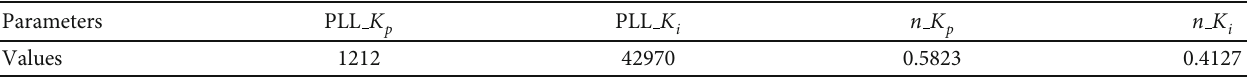
Figure 10: Flowchart for PSO algorithm optimization. Table 5: PI parameters of proposed method.